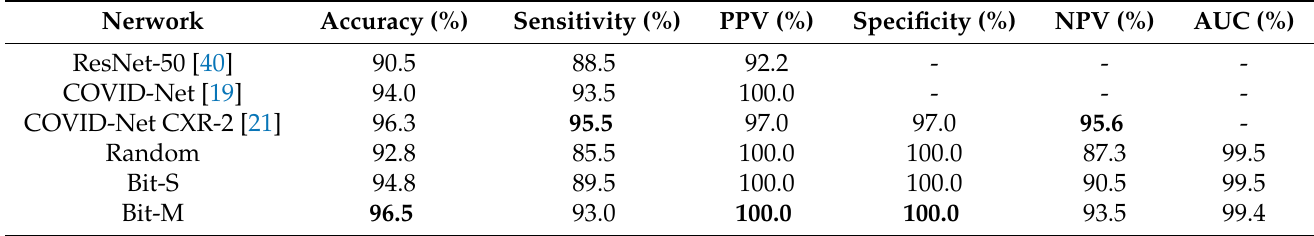
Table 1. Accuracy, Sensitivity, PPV, Specificity, and NPV of our different pretraining models on test data from COVIDx CXR-2 dataset. Best results highlighted in bold.